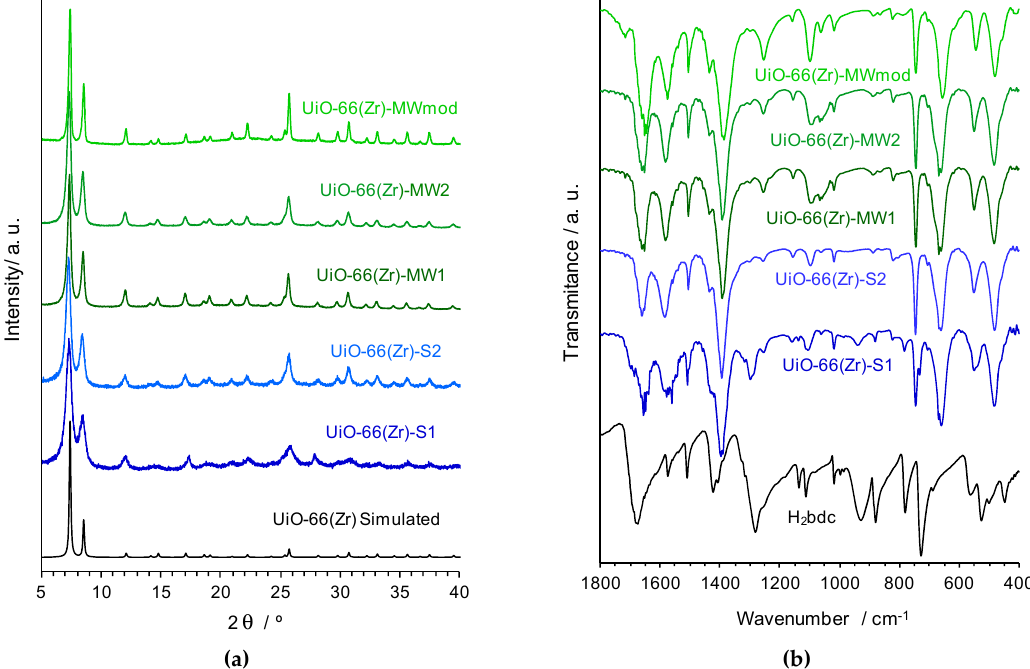
Figure 2. ( a ) powder X-ray diffraction (PXRD) patterns and ( b ) attenuated total reflectance operation mode (FTIR-ATR) spectra of the UiO-66(Zr) materials isolated by different synthetic methods, shown in the 2 θ range 5–40° and in the wavenumber region 1800–400 cm –1 , respectively.